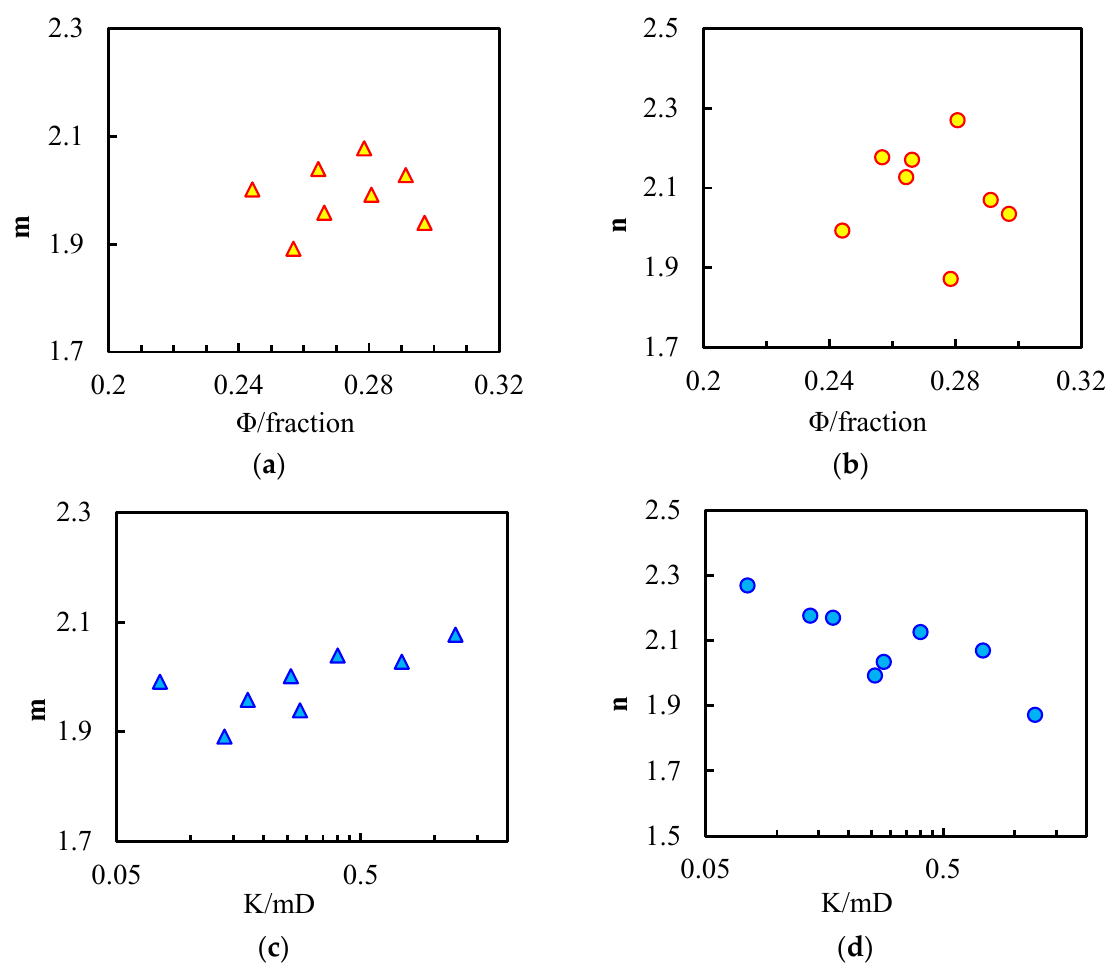
Figure 6. Relationship between physical properties and rock electrical parameters of core samples of the Quaternary mudstone biogas reservoir. ( a ) Relationship between m and Φ . ( b ) Relationship between n and Φ . ( c ) Relationship between m and K . ( d ) Relationship between n and K .